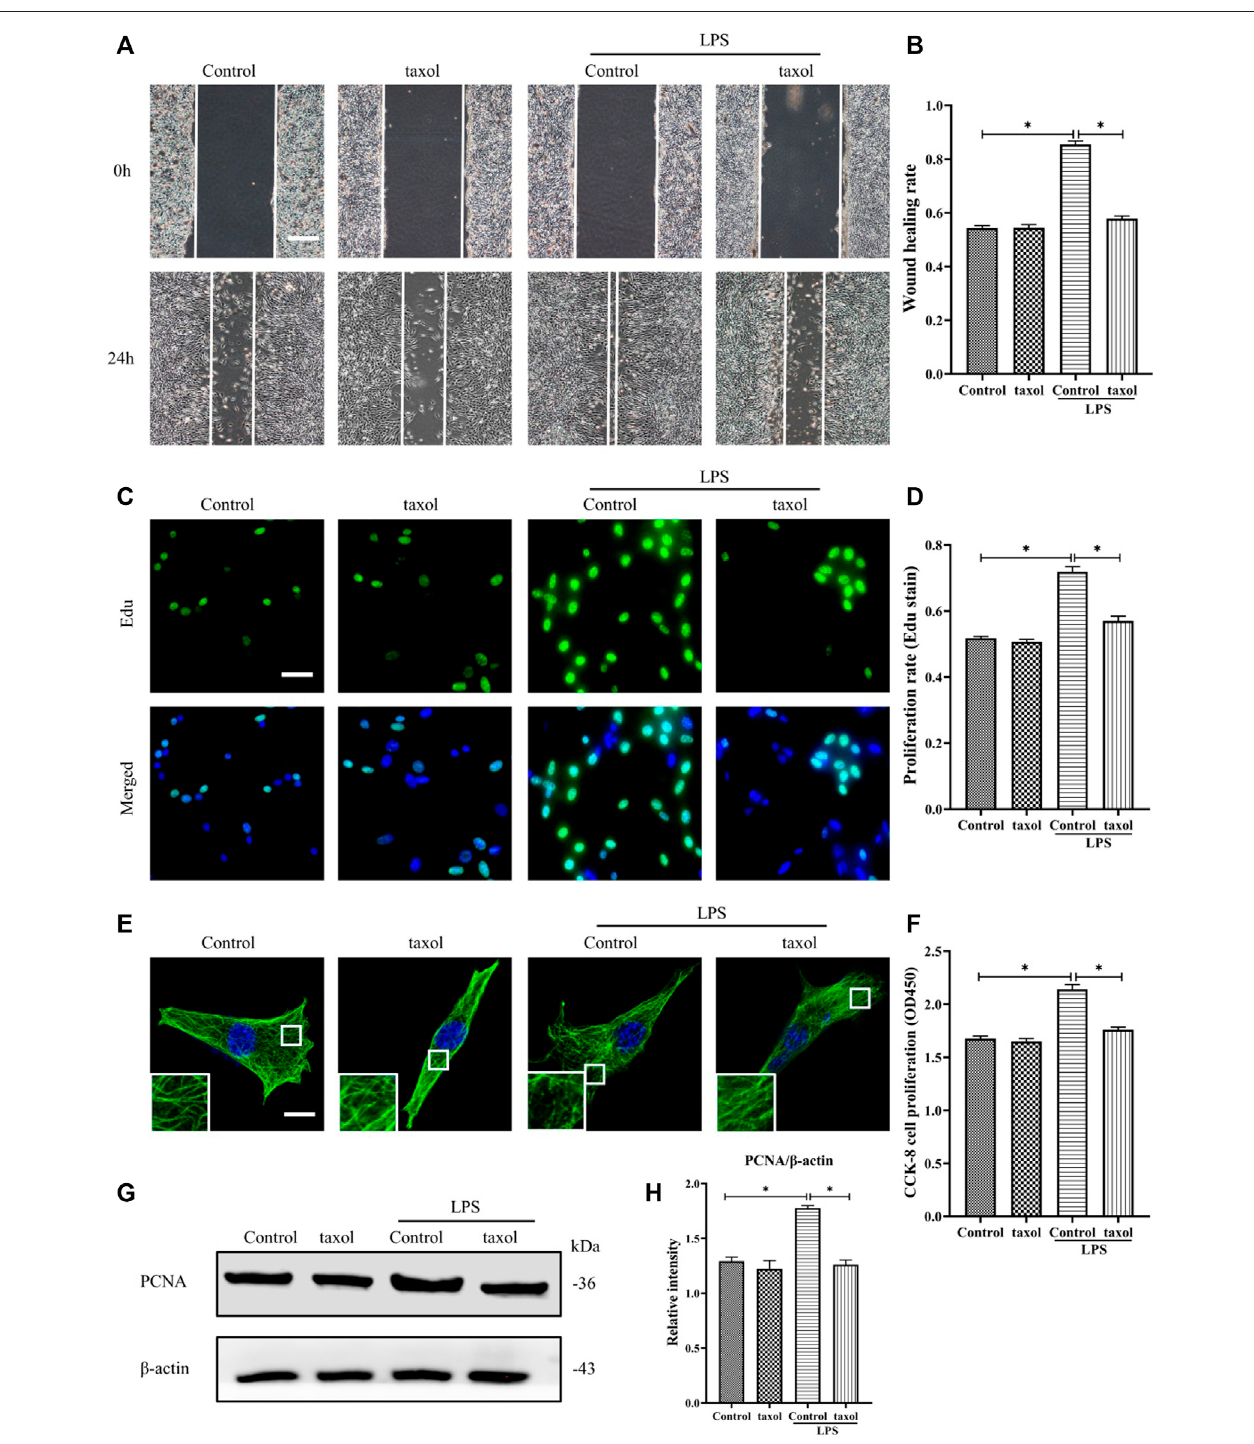
FIGURE2| InvolvementofMTdepolymerizationinLPS-inducedHDFmigrationandproliferation. (A) ScratchwoundhealingassayswereperformedtodetectHDF migration treated with LPS with or without taxol (1 µm) pretreatment, Bar, 200 μ m, and (B) quantitative analysis ( n (cid:1) 5). (C) HDF proliferation was detected after LPS treatmentwithorwithouttaxolpretreatmentbyEdustainingand (D) quantitative analysis( n (cid:1) 5).NucleiwerestainedwithHoechst 33342.Themerged imageistoshow the proportion of proliferating cells (green) to total cells (blue). Bar, 20 µm. (E) For the tubulin immuno fl uorescence images of MTs, cells were pretreated with taxol before LPS stimulation. These inserts show high-magni fi cation images of the peripheral MT network. Bar, 10 µm. (F) HDF was subjected to LPS with or without taxol pretreatment to detect cell proliferation using the CCK-8 assay ( n (cid:1) 10). (G) Western blotting was performed to detect PCNA after LPS treatment with or without taxol, and (H) the results were quantitatively analyzed ( n (cid:1) 5). The data are represented as the mean ± SEM. * p < 0.05 was considered to be signi fi cant.